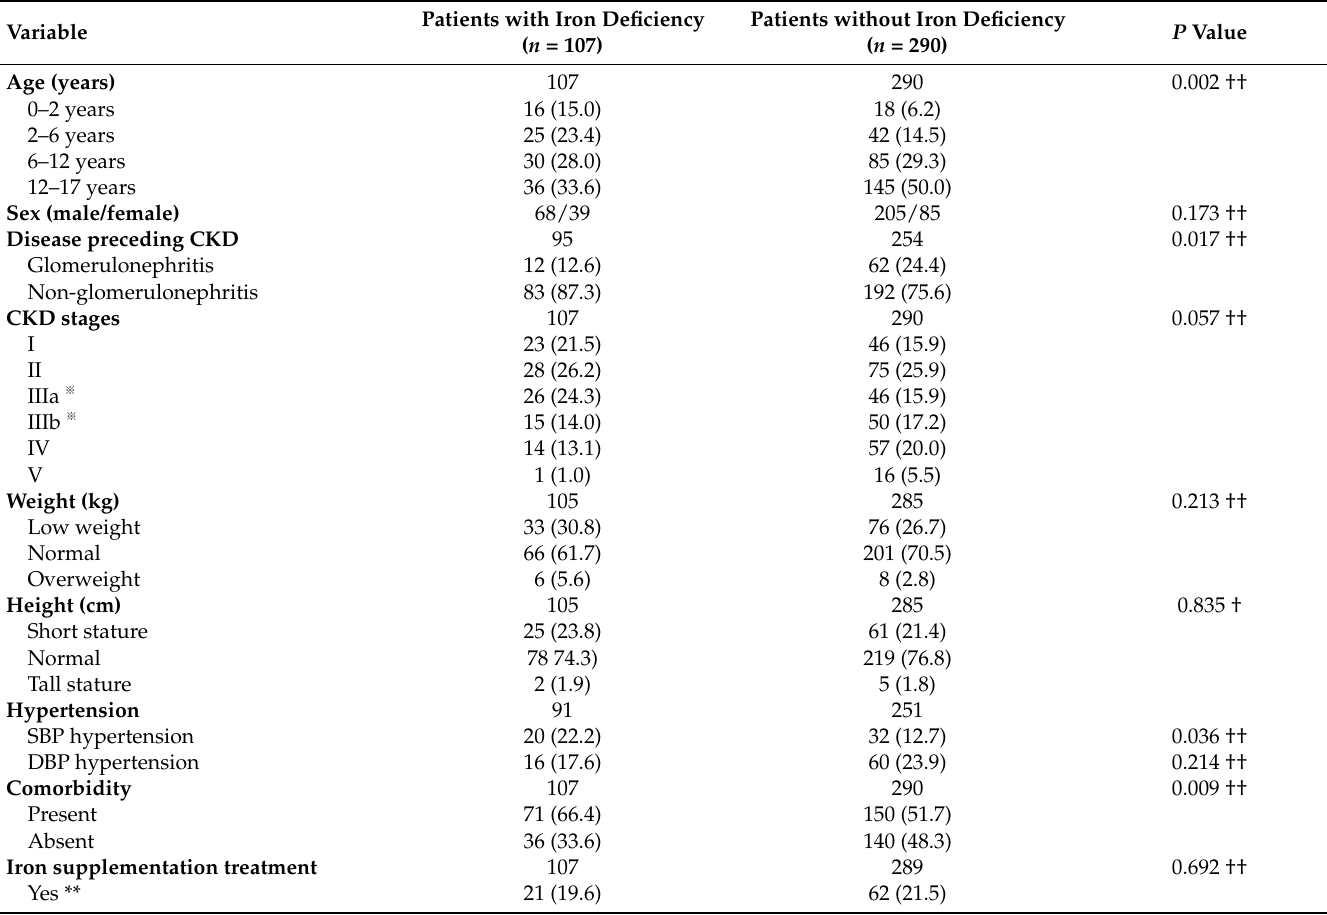
Table 8. Comparisons of characteristics of patients with iron deficiency in the CKD cohort.